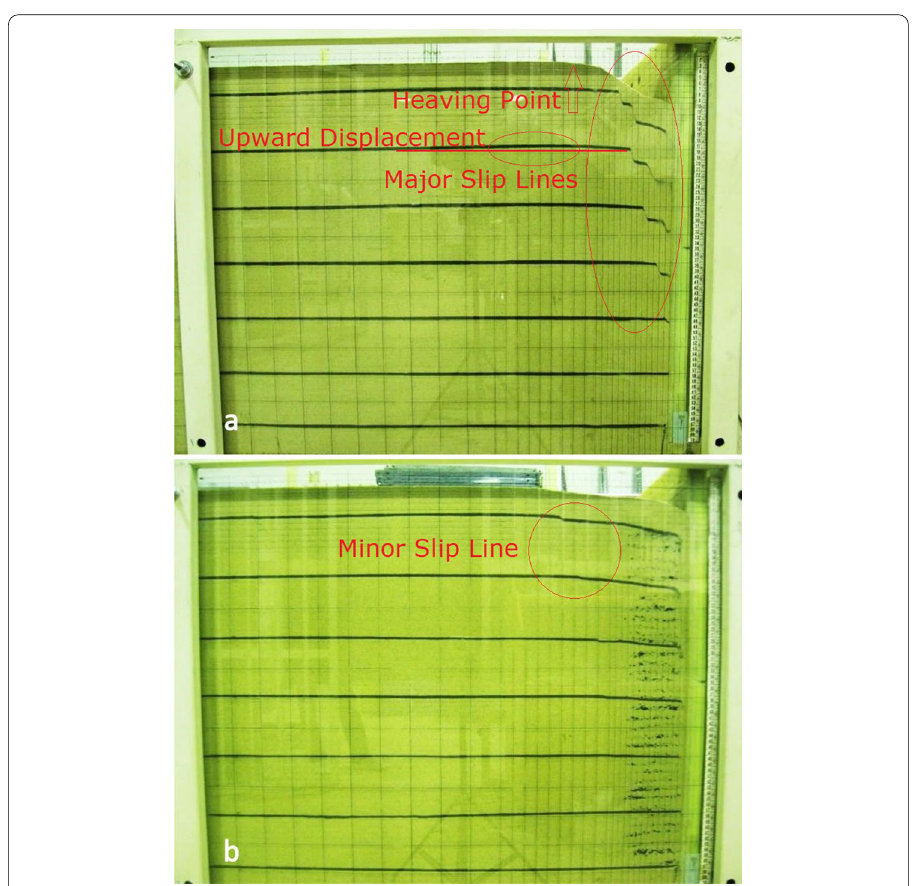
Fig. 19 Development of (a) an active shear zone and slip line during Test 1; (b) a significantly less pronounced surface settlement obtained when the reinforcement is applied (tire/area